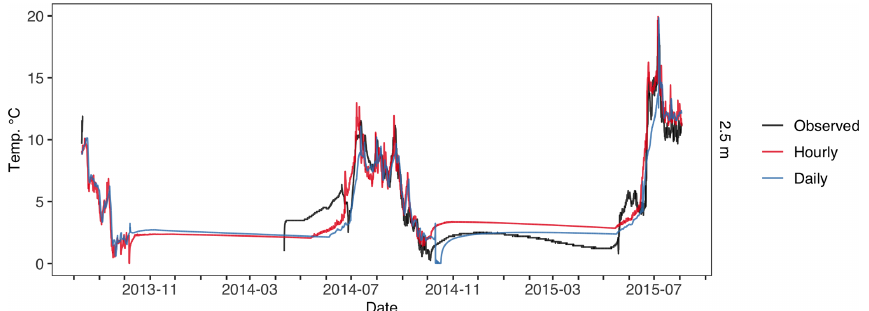
Figure F2. Atqasuk 2.5m water temperature across different temporal resolution simulations. Observed water temperature is in black, hourly temporal resolution is in red, and daily temporal resolution is in blue.